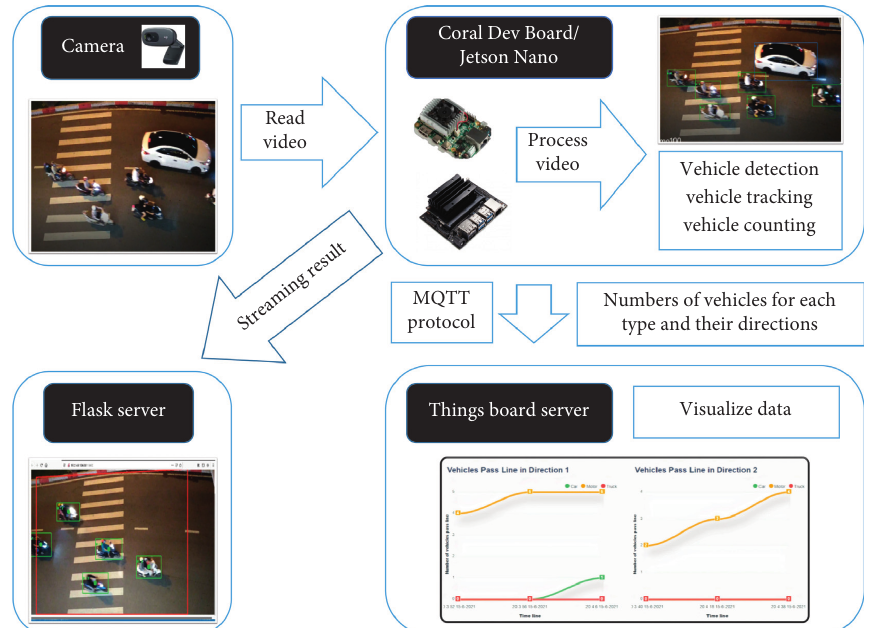
Figure 1: The architecture overview of the proposed edge-based system for traffic flow detection. Vehicle detecting, tracking, and counting are directly performed on edge devices (e.g., Google Coral Dev Board and Nvidia Jetson Nano).